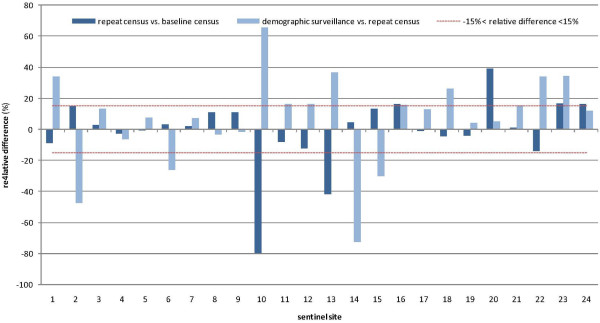
Relative difference (as percent) between baseline census, repeat census, and demographic surveillance, by site.